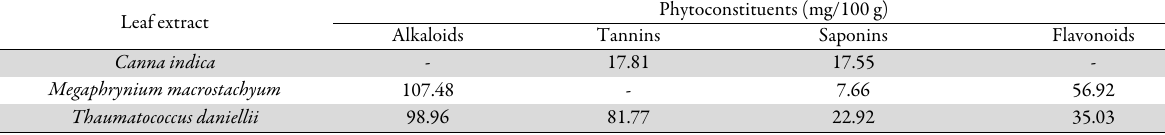
Table 2b. Quantitative phytochemical determination of leaf extracts of test plants Leaf extract